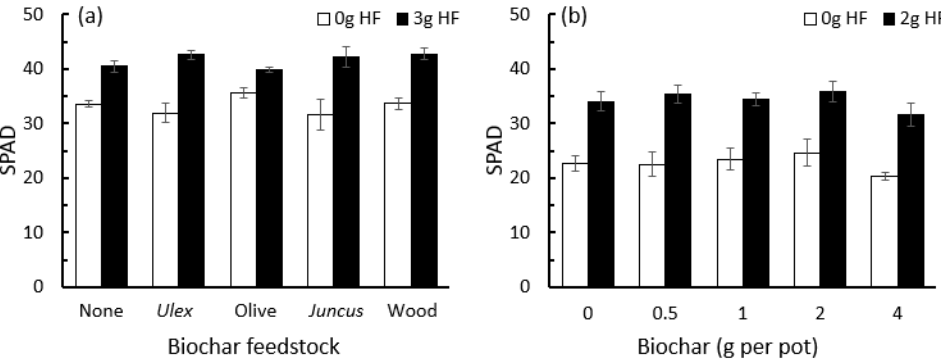
Figure 6. The chemical content (% dwt) of barley foliage grown under greenhouse conditions in response to different application rates (g per pot) of HexaFrass and olive stone biochar (BC). Biochar was only applied for the 0 g and 4 g HexaFrass treatments.